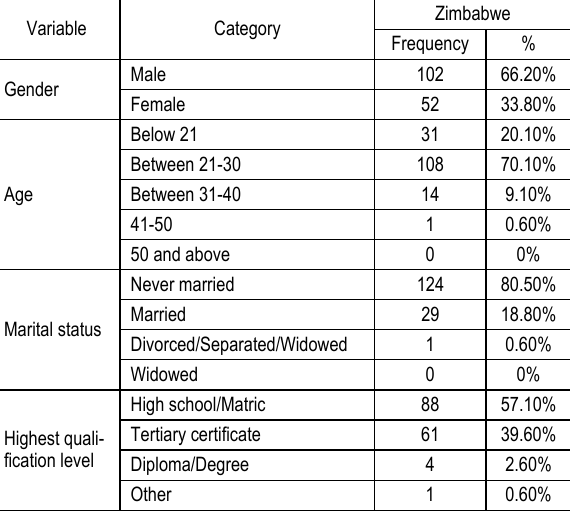
Table 1. Demographic profile of respondents